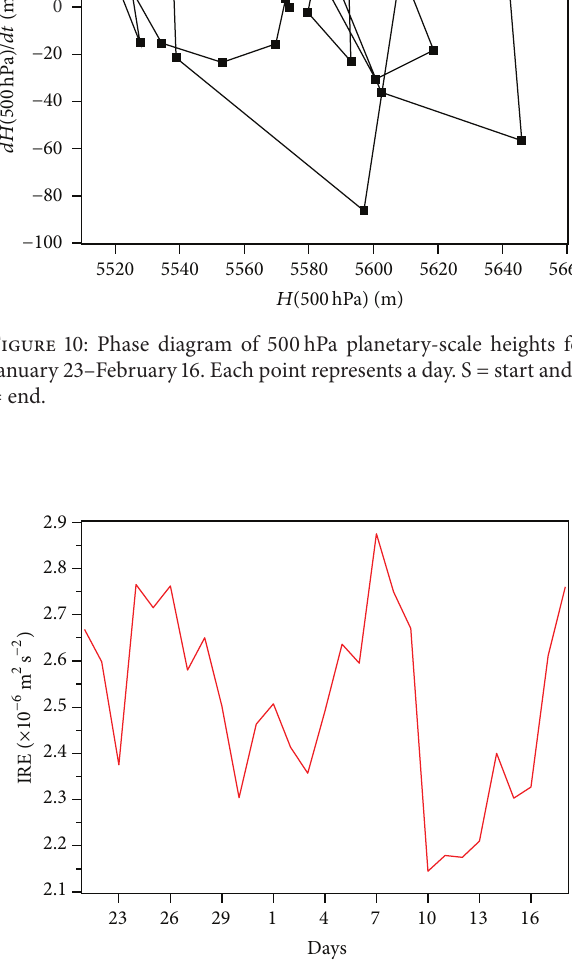
Figure 11: Integrated enstrophy (IRE) for January 21–February 18.